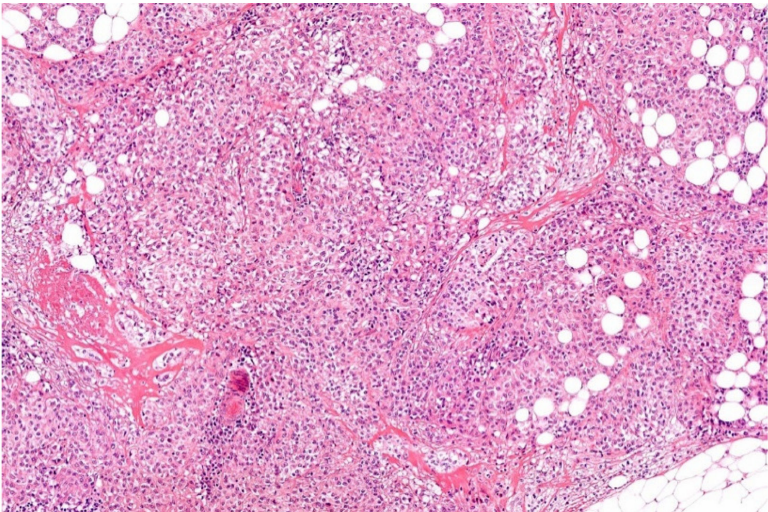
Figure 9. Mesothelioma consist sheets and nests of uniform epitheloid tumor cells with enlarged nuclei and eosinophilic cytoplasm (HE; 20 ×